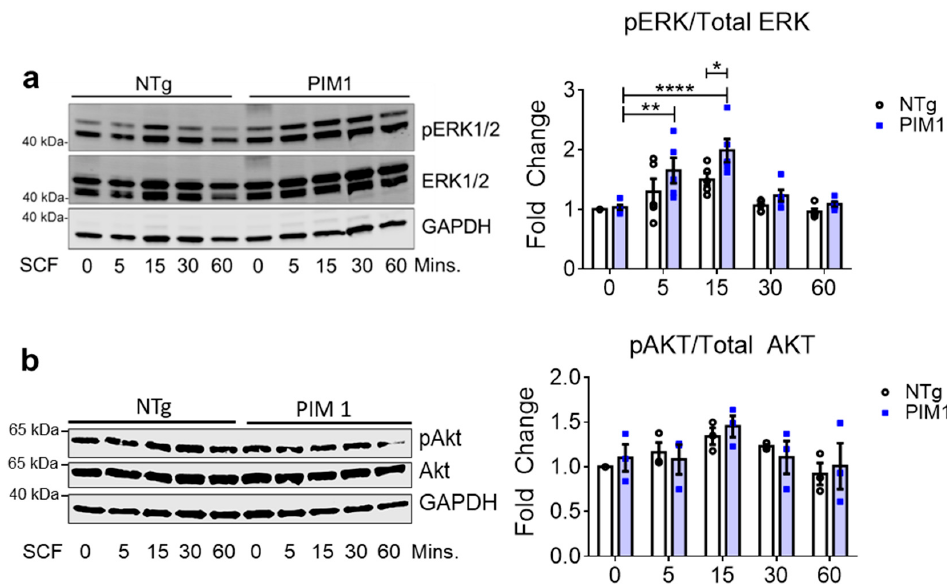
Figure 3. Cardioprotective signaling downstream of c-Kit is elevated in PIM1 cardiomyocytes. ( a ) Immunoblot analysis of activated ERK1 / 2 and ( b ) activated AKT in NTg and PIM1 cardiomyocytes following treatment with SCF over 60 min. Quantification is shown on the right. N = 5, Error bars represent SEM, * p < 0.05, ** p < 0.01 and **** p < 0.0001 as measured by two-way ANOVA multiple comparison with Tukey.